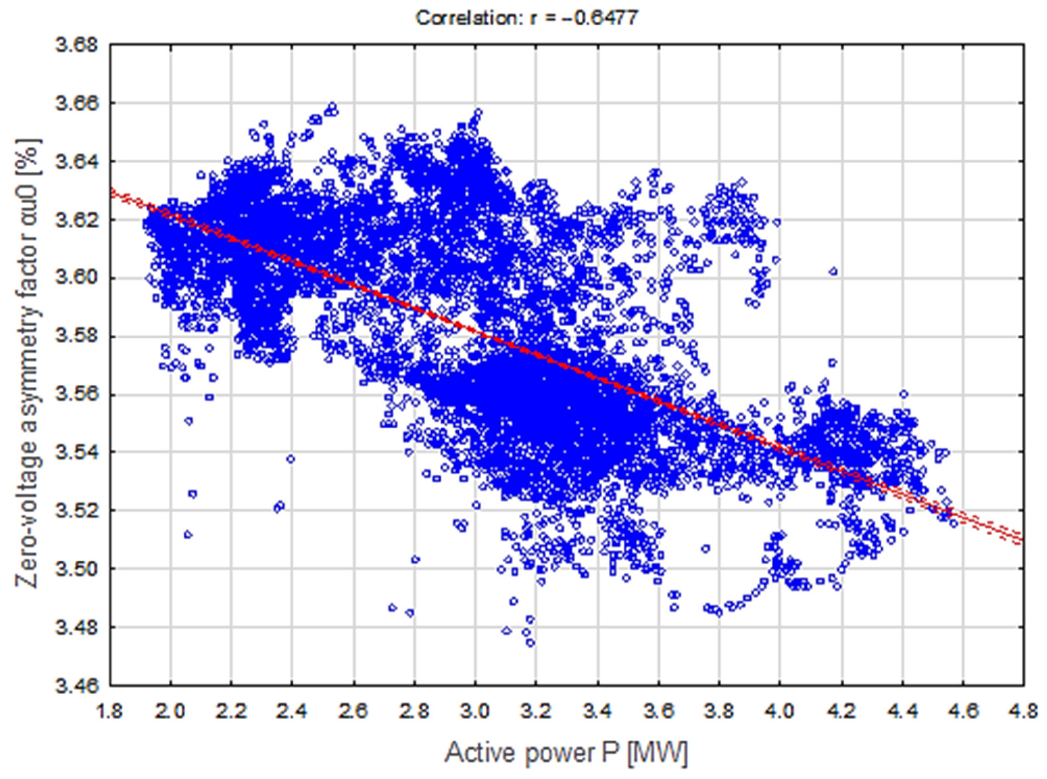
Figure 9. Dependence diagram of the zero-voltage asymmetry factor ( α u0% ) on the active power of the load (P), determined during field tests.